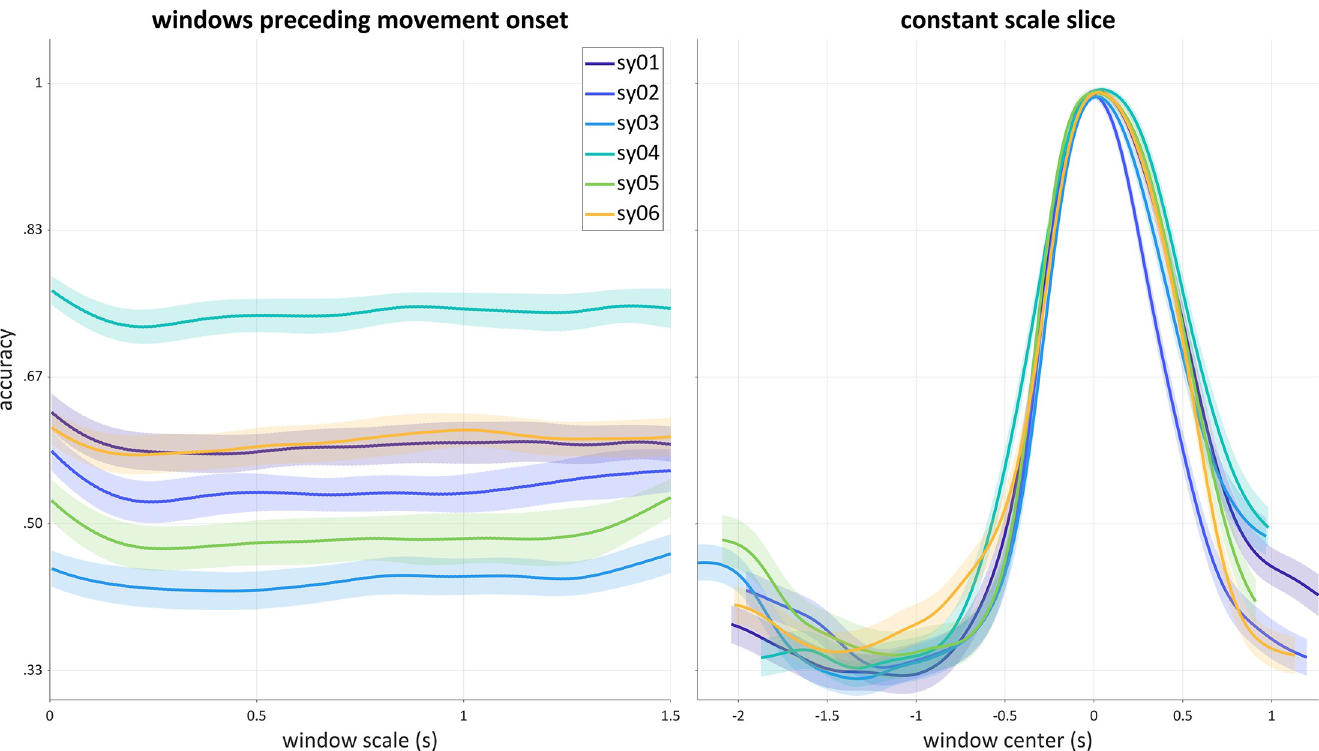
Fig 7. Accuracy slices for all six speakers in the syllable production dataset. Left: accuracy as a function of scale for windows whose right edge is aligned with the 5 th percentile of onset consonant movement initiation (dotted lines in Fig 6). Right: accuracy as a function of window center with constant scale of 0.250 seconds.